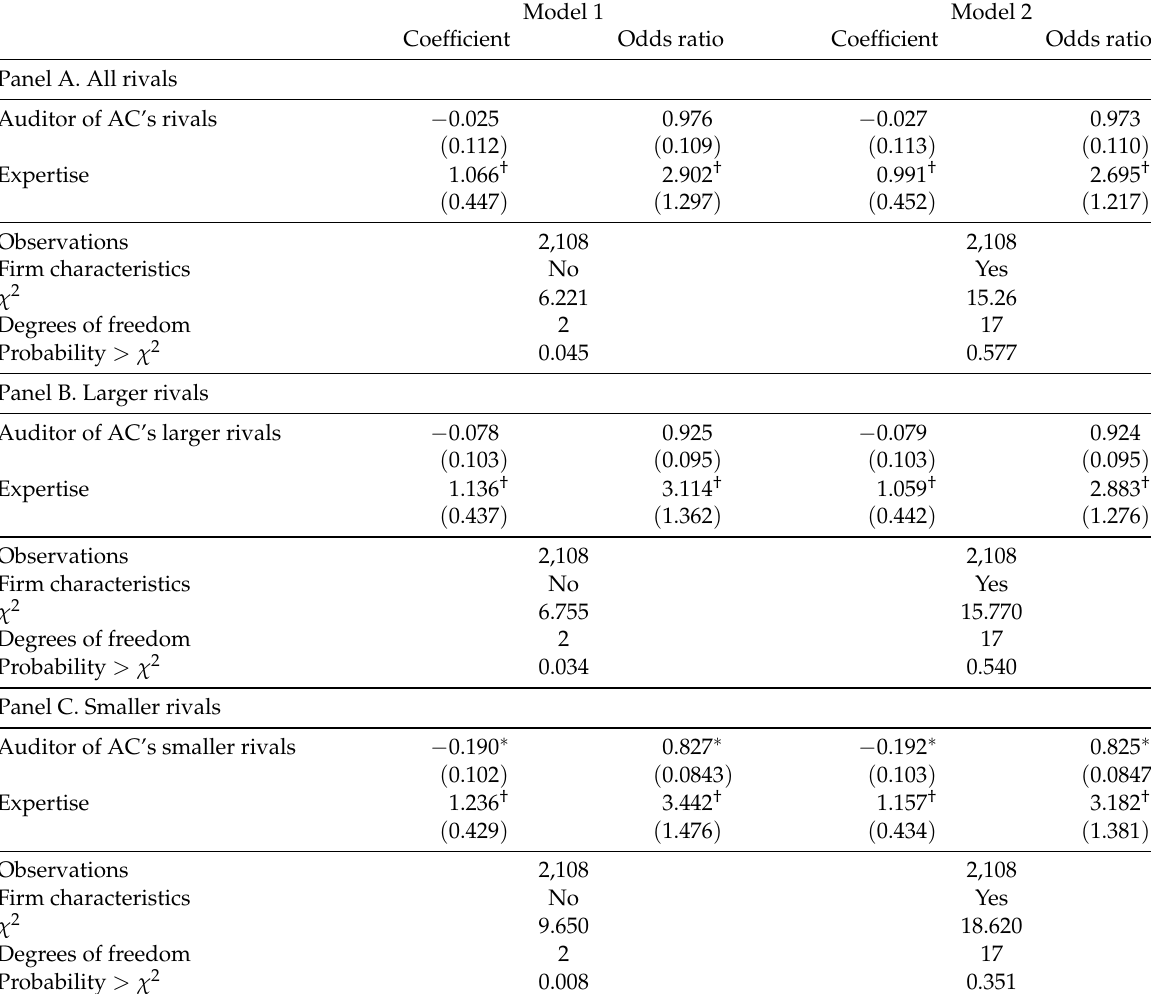
Table 3: McFadden’s choice models of post-shock auditor